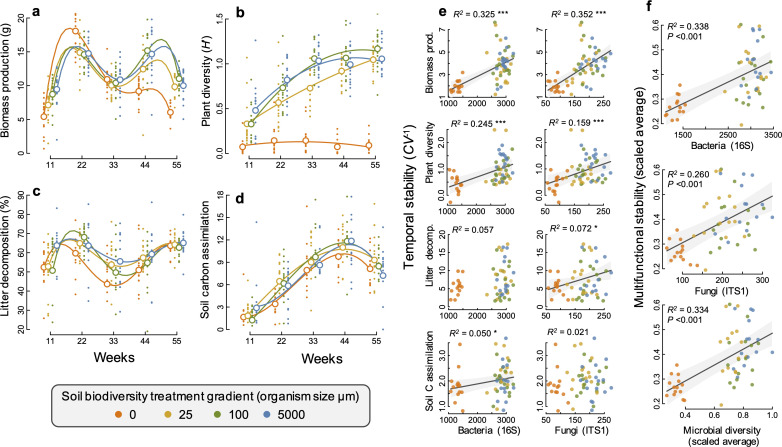
Changes in ecosystem functions through time and relationships between soil microbial diversity and multifunctional stability.(a) Plant biomass production, (b) plant diversity, (c) litter decomposition, and (d) soil carbon assimilation, measured as the δ13C in the soil and scaled by the minimum value such that larger positive values indicate a greater amount of δ13C detected in the soil. Individual points are data from individual mesocosms and larger open points are the means for each time point and soil biodiversity treatment level. Polynomial regression lines are shown to highlight the temporal trends. (e) The relationship between the temporal stability (the inverse coefficient of variation, CV−1) of each of the four functions and the richness of bacteria and fungi. (f) Multifunctional stability, calculated as the scaled average of the stability of each of the four ecosystem functions shown in relation to the richness of bacteria, fungi, and microbial diversity (the scaled average of fungal and bacterial richness) are all highly significant. Regression lines and 95% confidence bands are shown for significant relationships (p<0.05).